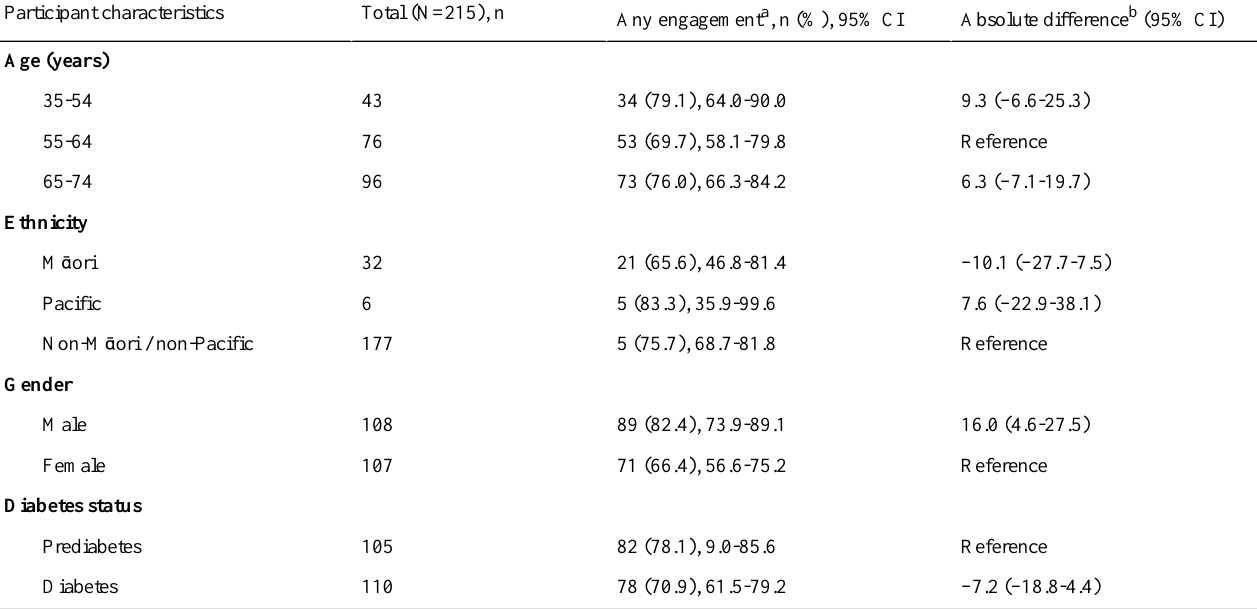
Table 1. Patterns of any engagement (at any time in program) by key participant